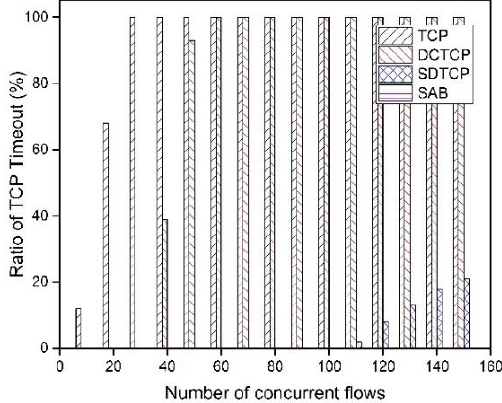
Figure 10. Ratio of timeout with fixed flow size.